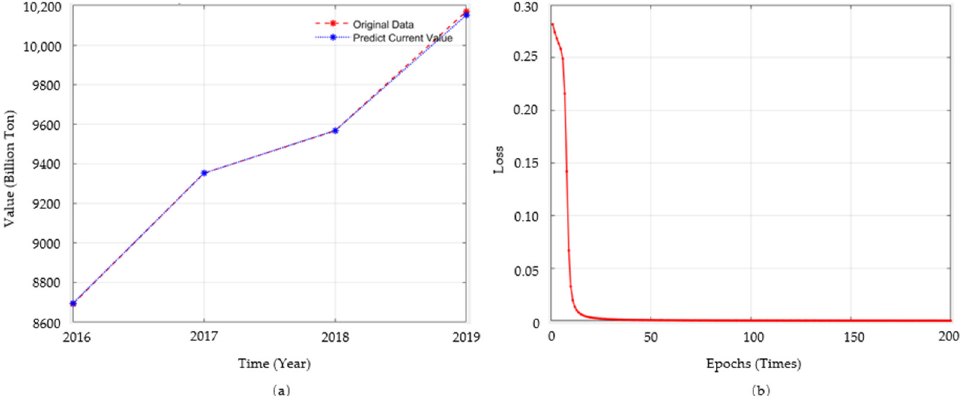
Figure 3. Prediction results of BP neural network (multi-layer) model. ( a ) The prediction of data on CO 2 emissions in the past. ( b ) The learning and training process of this model. Forecast data on green credit balance, green bond scale and green project investment are used as hidden neurons to predict CO 2 emissions by the BP neural network model, that is, the green credit balance, green bond scale and green project investment are seen as influencing variables for CO 2 emissions. Moreover, the predicted value of China’s CO 2 emissions from 2020 to 2060 is obtained, as shown in Figure 4.